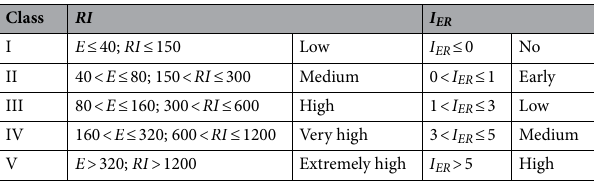
Table 4. Classification of risk degree of RI and I ER .